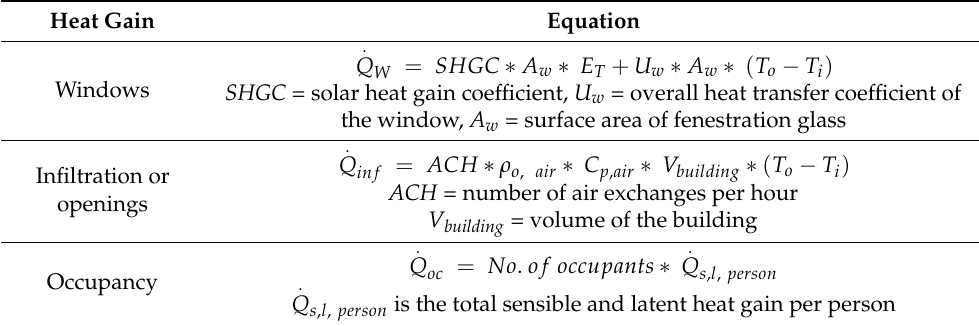
Table 2. Equations related to the evaluation of heat gain in the building